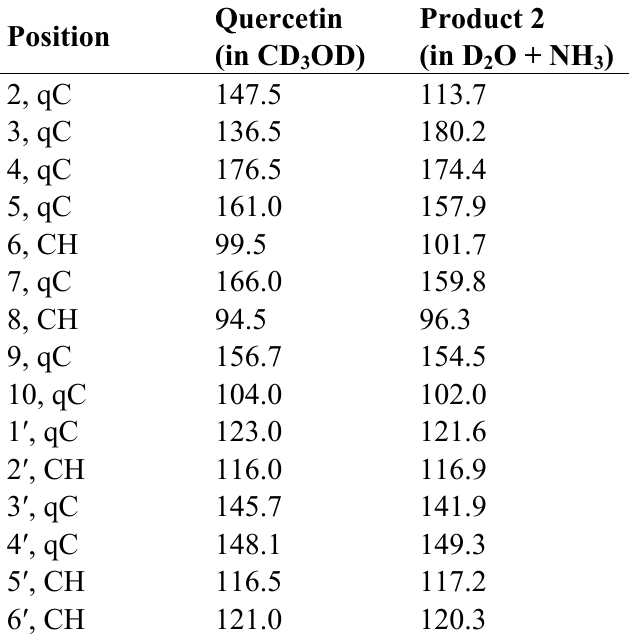
Table 1. 13 C-NMR spectroscopic data (75 MHz) for quercetin and product 2